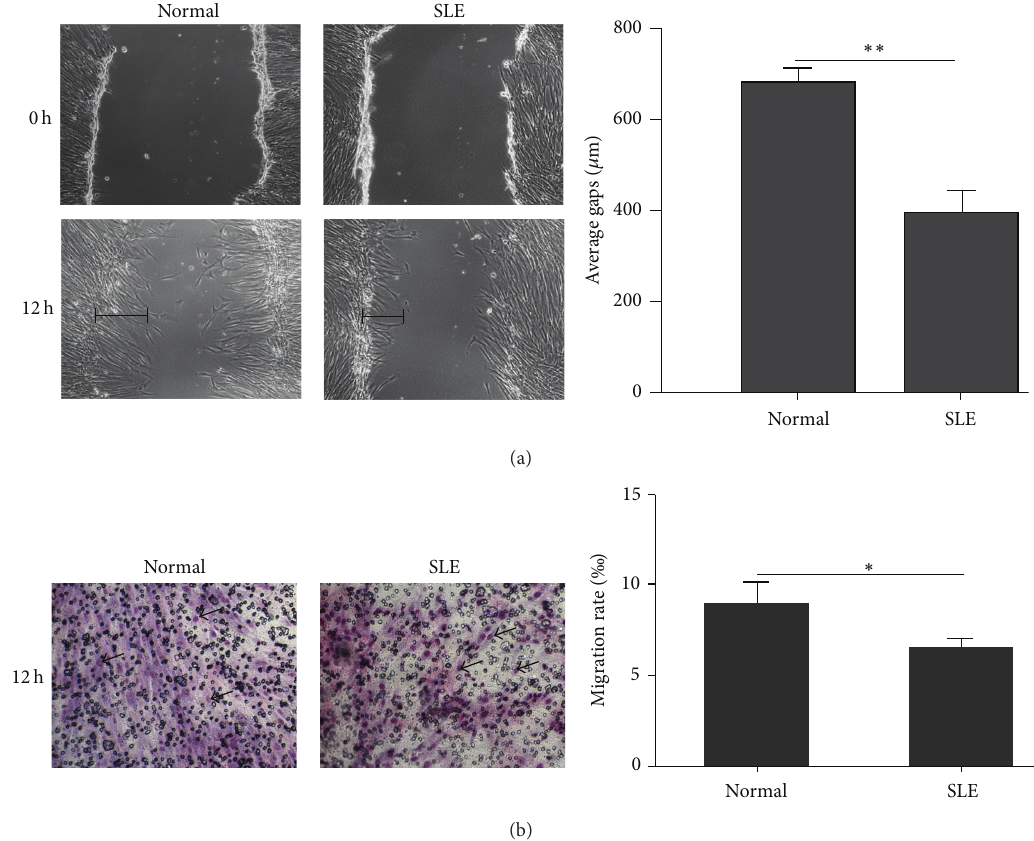
Figure 1: Migration capacity was significantly decreased in BMSCs from SLE patients. (a) The scratches healed faster in BMSCs from healthy controls than that from SLE patients 12 hours after the scratch experiments. The length of average healed gaps was illustrated by the black line. (b) The migration rate of BMSCs from SLE patients was remarkably reduced compared with that of healthy controls by transwell migration assay. Migrated BMSCs stained in Giemsa solution (marked by black arrows in the figure) were quantified by image pro-plus 6.0 software to obtain the migration rate per morphologic field randomly selected. ∗ 𝑃 < 0.05 , ∗∗ 𝑃 < 0.01 .